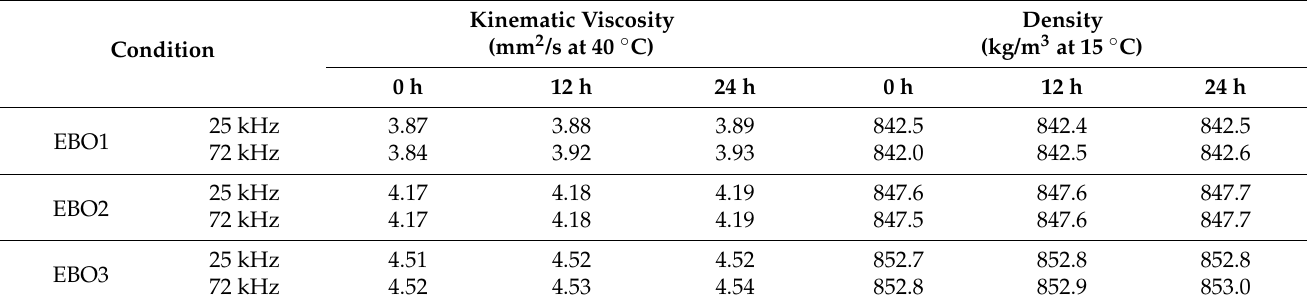
Table 2. Variation in kinematic viscosity and